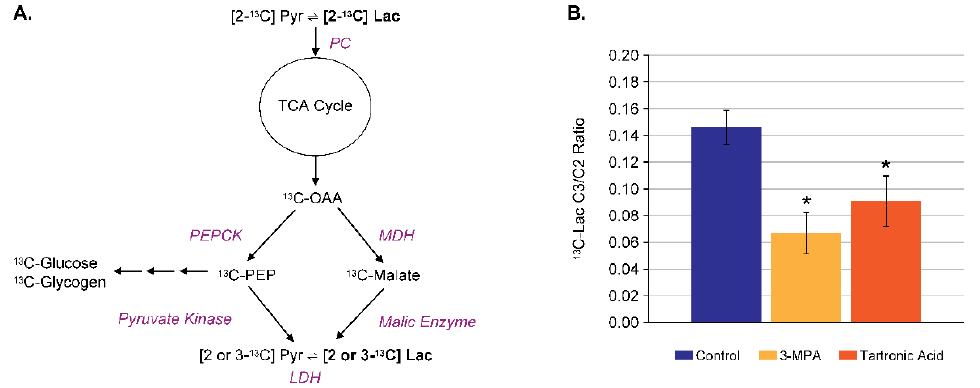
Figure 8. The assessment of pyruvate cycling in perfused liver. ( A ) Schematic of the main pyruvate cycling pathways in liver, where [2- 13 C] pyruvate can be recycled to [3- 13 C] pyruvate via the combination of (1) PEPCK and pyruvate kinase, or (2) malate dehydrogenase and ME1. ( B ) The effect of the PEPCK inhibitor (3-MPA) and the ME1 inhibitor (tartronic acid) to reduce the ratio of [3- 13 C] lactate to [2- 13 C] lactate, a biomarker of pyruvate cycling. * P < 0.05 compared to Control.